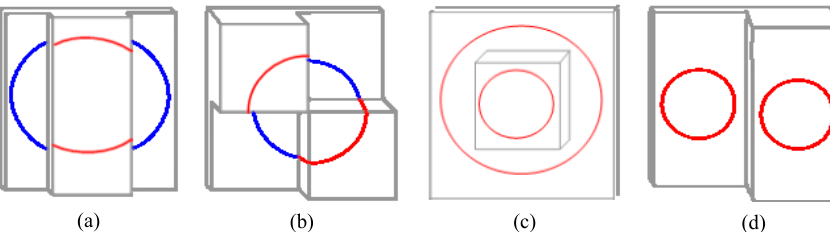
Figure 4. Combination forms of laser and target. ( a ) Single ring stripe laser and parallel planar target; ( b ) Single ring stripe laser and parallel planar target; ( c ) Concentric double ring stripe laser and parallel planar target; ( d ) Multiple ring stripe laser and parallel planar target.